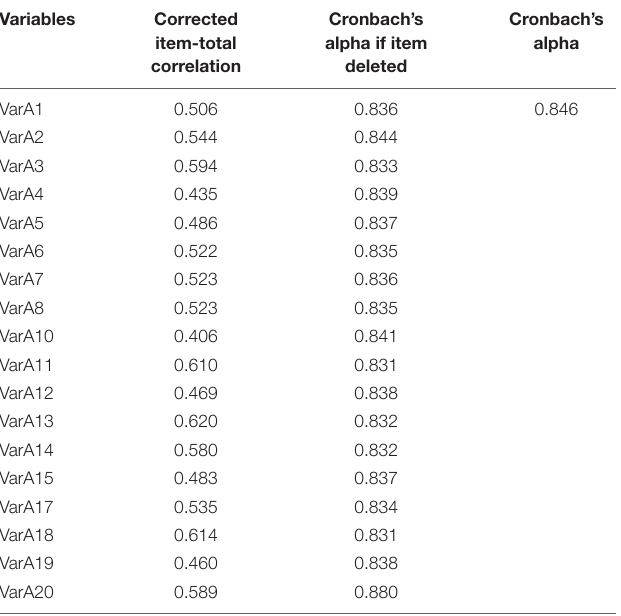
TABLE 5 | Reliability analysis of the initial CETPE Scale ( N =